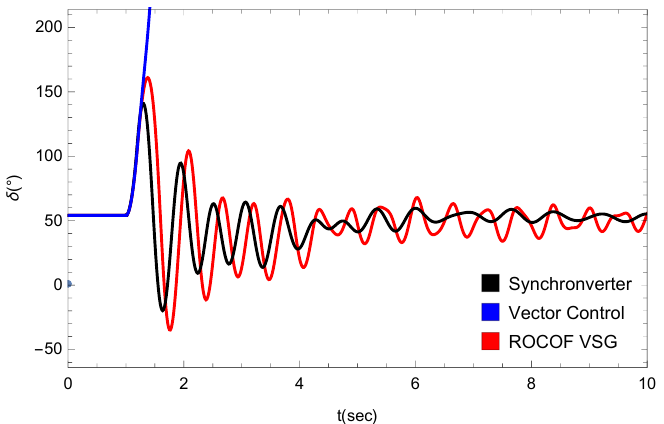
Figure 10. IEEE 9 bus: Load angle of 3 generator during 3 phase fault for t cl = 0.2